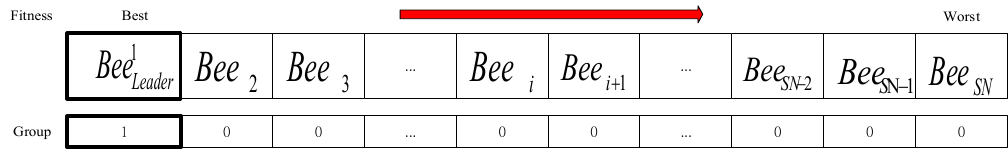
Figure 9. The bee with the best fitness is set as leader.